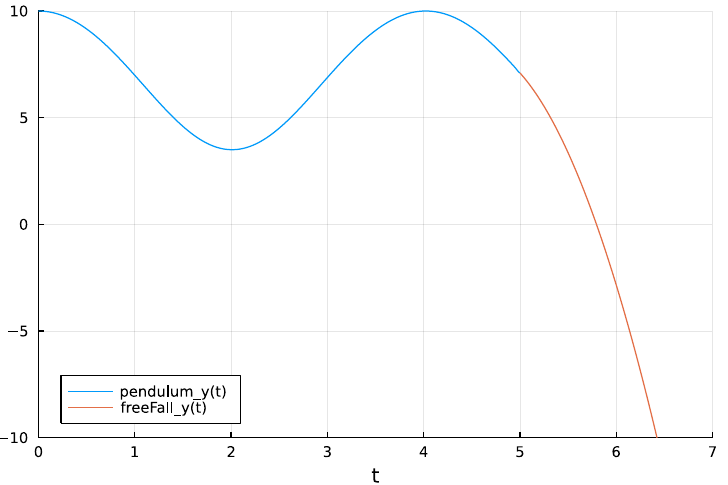
Figure 9. The result of simulating the breaking pendulum using recompilation during simulation. The code to obtain this plot is presented in Listing